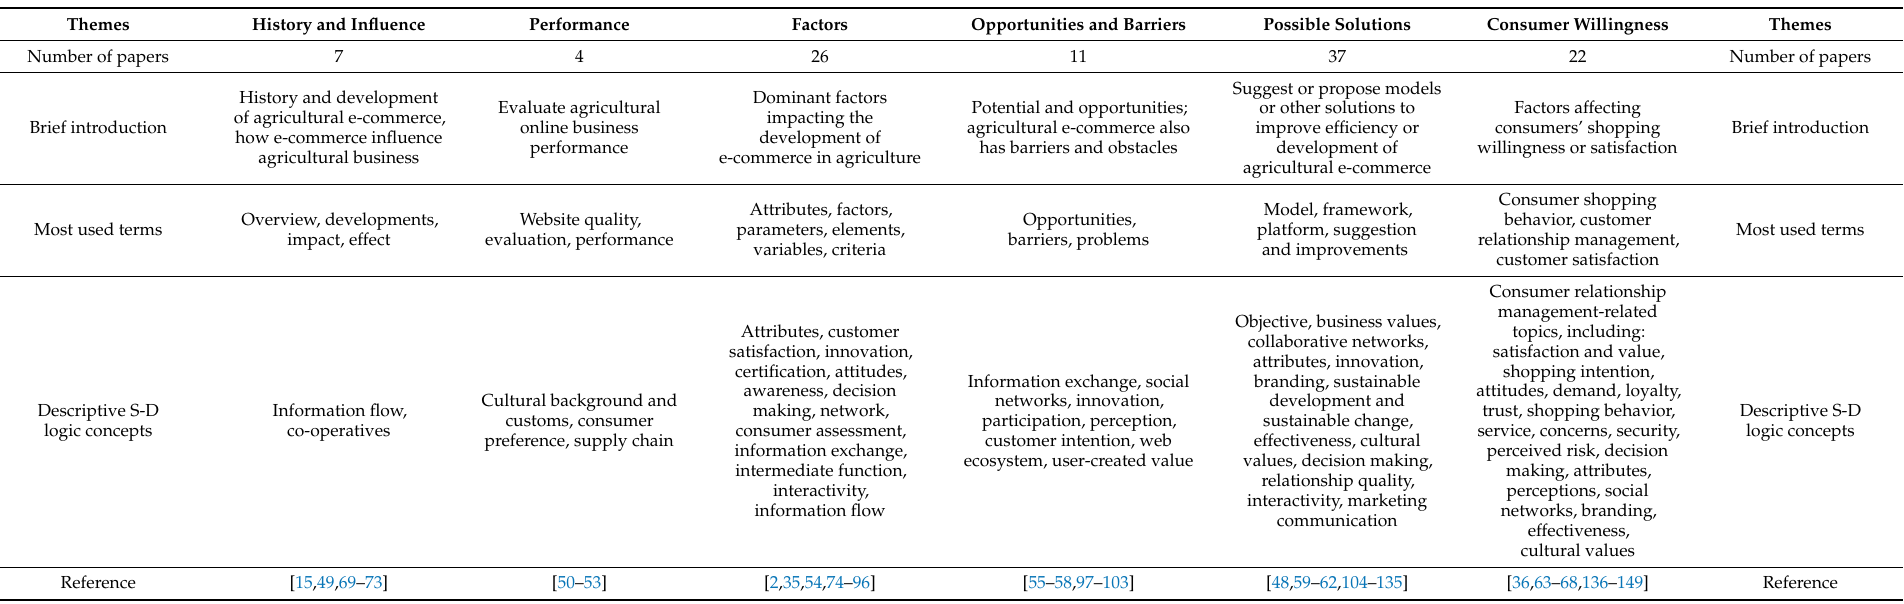
Table 1. Articles classified into the themes